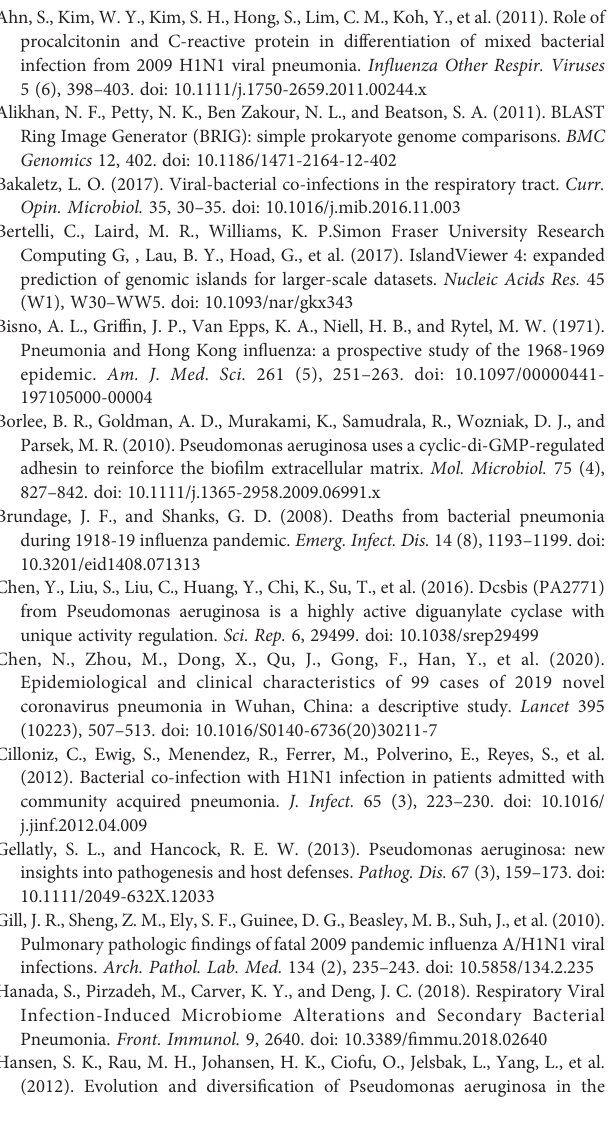
paranasal sinuses of cystic fi brosis children have implications for chronic lung infection. Isme J. 6 (1), 31 – 45. doi: